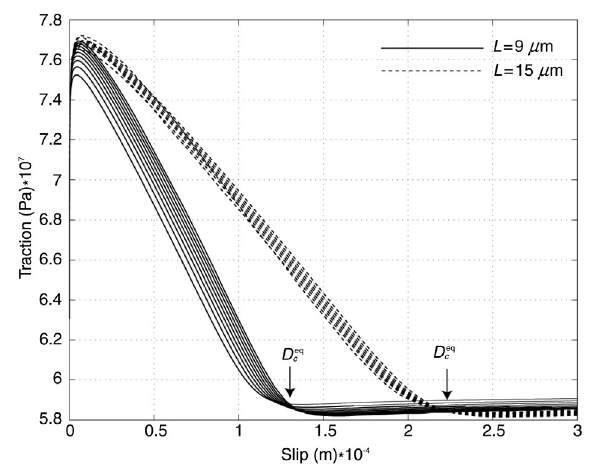
Fig. 6. Slip-weakening curves calculated for the simulation shown in the previous figure, whose model and constitutive parameters are listed in table III. The traction evolutions as a function of slip have been plotted for several points located on the two patches having different values of L parameter at different distances from the nucleation